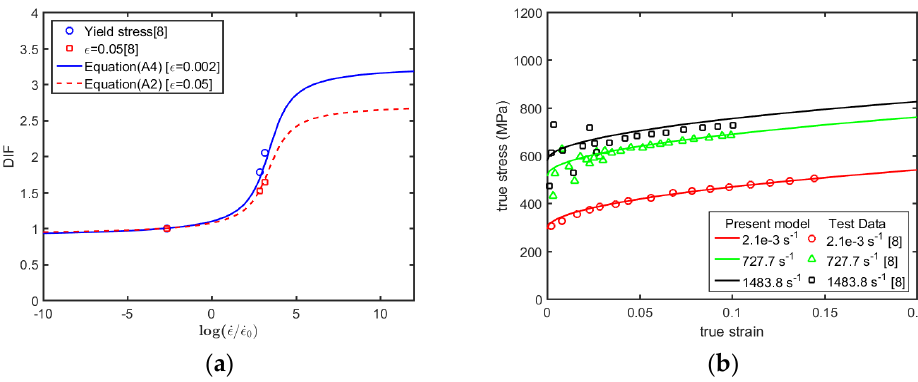
Figure A1. Comparison of the present model with the test data for Q235 mild steel. ( a ) DIF at different plastic strains versus strain rate at room temperature; and ( b ) true tress-true strain curves in compression.